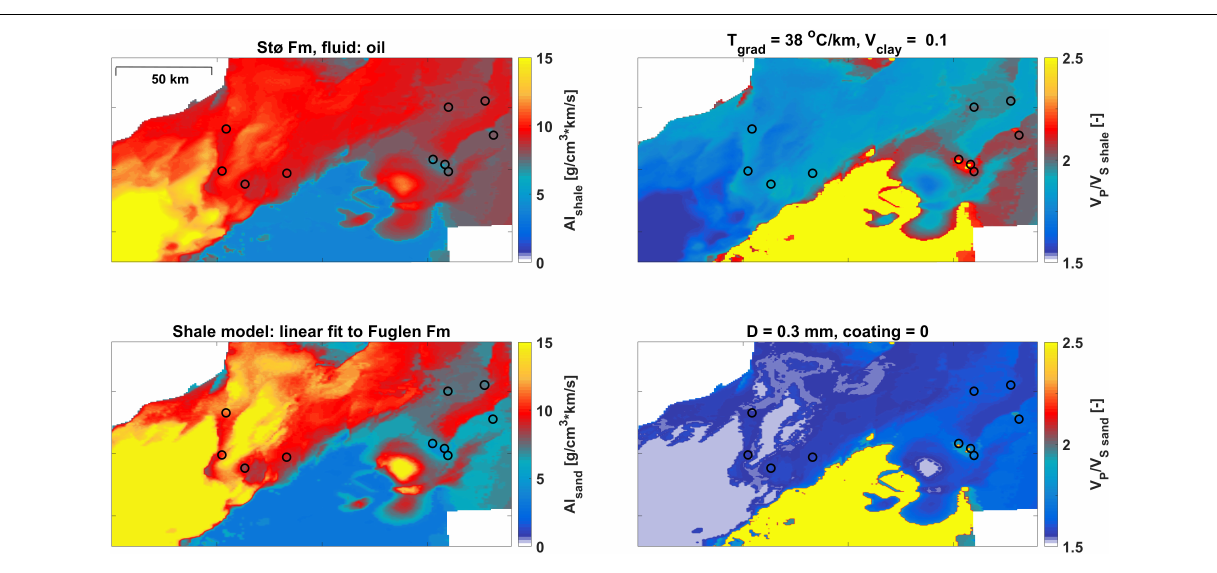
FIGURE 9 | Elastic property feasibility maps for a given geological scenario. Upper: Expected acoustic impedance and V P /V S of cap-rock Fuglen Fm shale; Lower: Expected acoustic impedance and V P /V S for brine-filled reservoir sandstone of Stø Fm. Note that these maps are modeled values for shales and sandstones constrained by the burial maps (i.e., net erosion) in Figure 6 , which are again derived from the seismic velocity